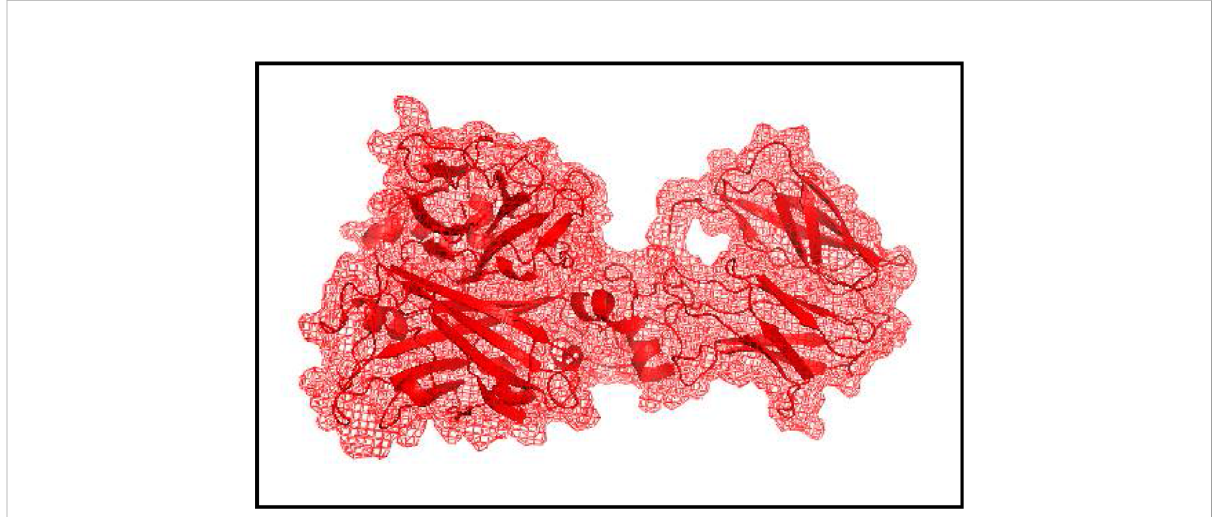
FIGURE 1 The structure of the molecular target, the bio fi lm-associated protein (BAP) after the removal of water molecules and HETATM. The BAP was downloaded from RCSB protein data bank (PDB ID: 7C7U, Ma et al. 2021a; Ma et al. 2021b) and modi fi ed structure was created using Biovia Discovery Studio